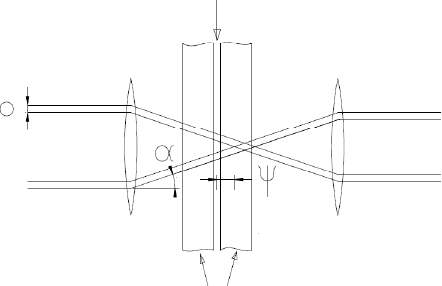
Fig. 10. Distance  from the chamber middle plane and the common focus (of left and right hand side lenes l and l ). The laser beam is focused onto the l r disc, centered in the common focus of radios 